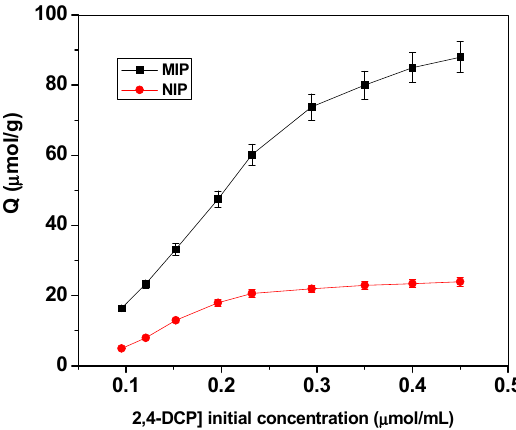
Figure 4. Binding isotherm for MIPs and NIPs. Conditions: 20.0 mg of polymer; t=25 °C; V=10.0 mL.